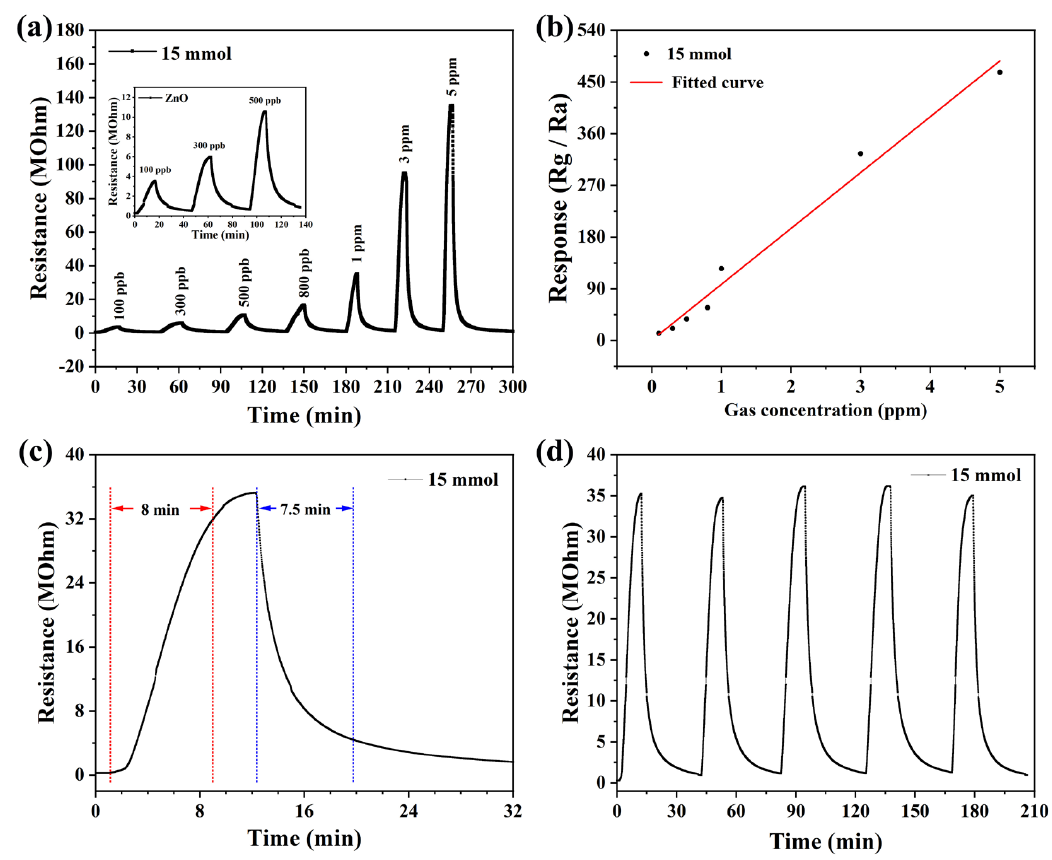
Figure 6. The performances of sensor to NO 2 at 125 °C: ( a ) Transient curve, ( b ) the linear relationship of the sensor to NO 2 in the range of 0.1 ppm to 5 ppm, ( c ) the characteristic of response–recovery curves to 1 ppm, ( d ) five periods of response curve to 1 ppm.